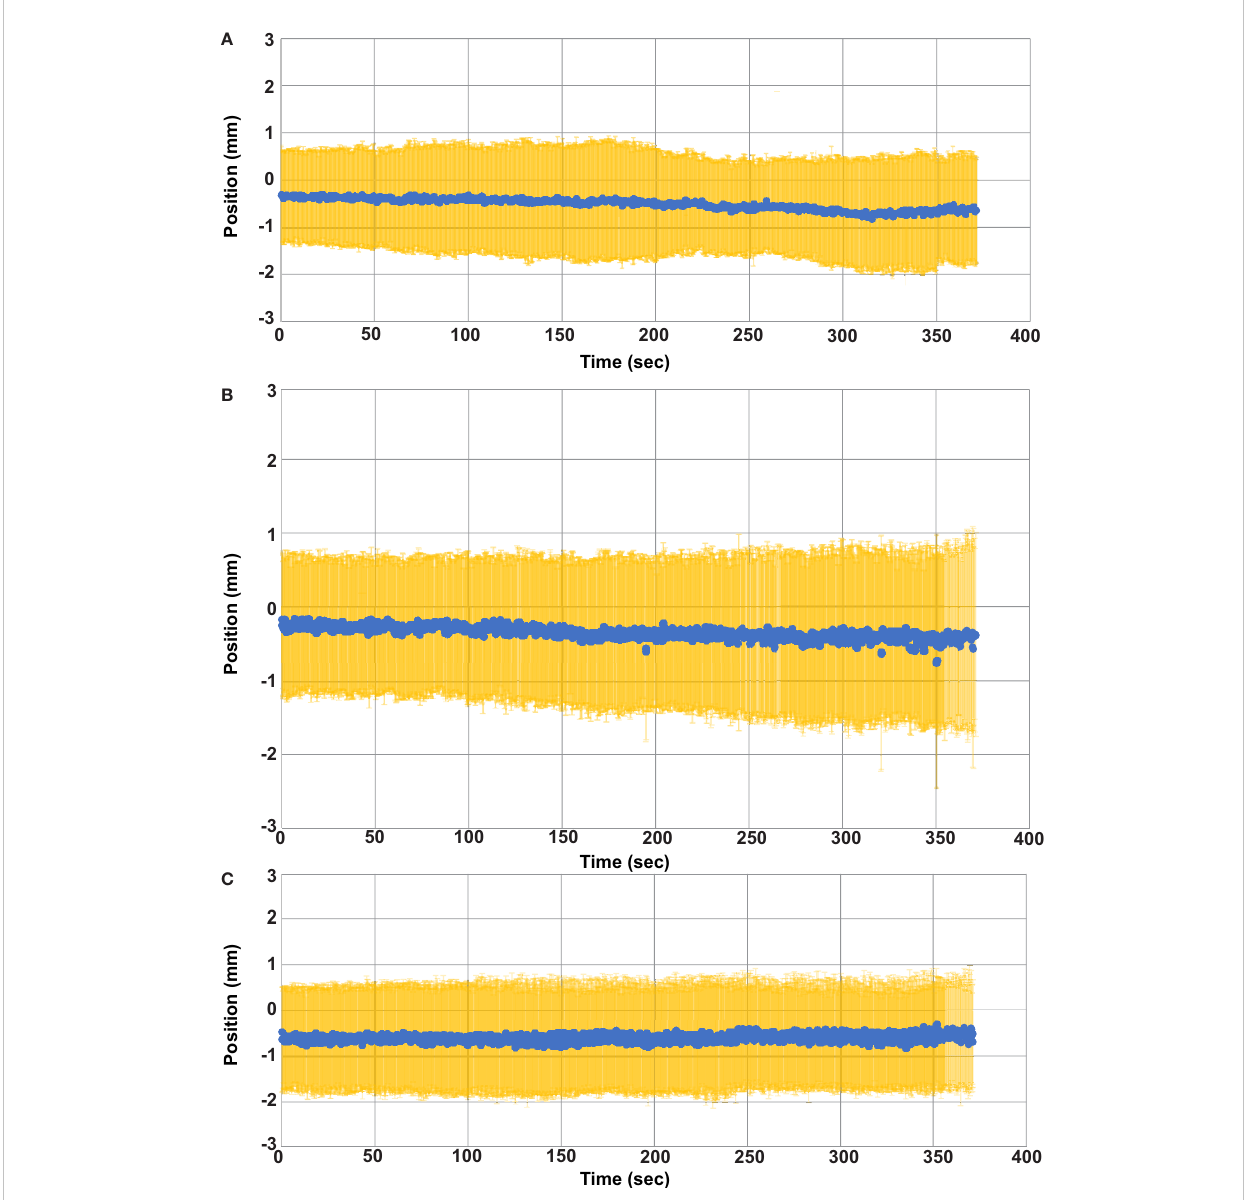
FIGURE 4 Average GTV Position versus time. The average GTV position (blue) and standard deviation (yellow) for all fractions is plotted as a function of time. (A) GTV position in the left (+) and right (-) direction. (B) GTV position in the anterior (-) and posterior (+) direction. (C) GTV position in the superior (+) and inferior (-)